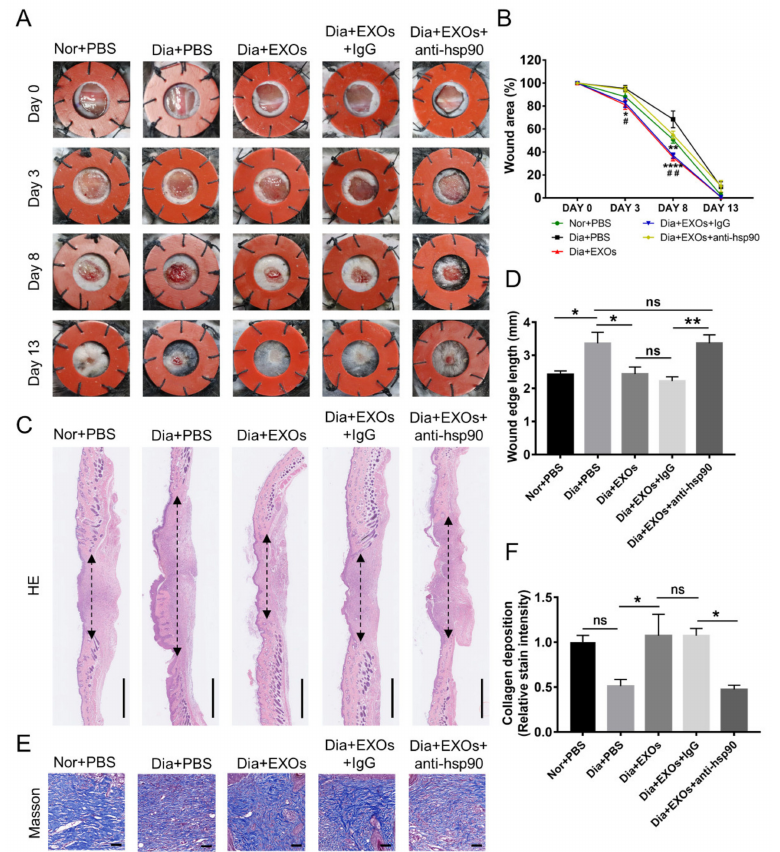
Figure 6. ADSC-EXOs accelerated skin wound healing in diabetic mice via eHSP90. ( A ) Representa- tive images of skin wounds at days 0, 3, 8, and 13. ( B ) Quantitative analysis of the wound-closure rates in different treatment groups; * vs. Dia + PBS, # vs. Dia + EXOs + anti-hsp90. ( C ) H & E staining analysis of wound sections on day 13 post wounding; the double-headed arrows represent edges of the granulation; scale bar: 1 mm. ( D ) Quantification of the wound edge length shown in ( C ). ( E ) Evaluation of collagen deposition by Masson’s trichrome staining in each group; scale bar: 50 µ m. ( F ) Qualification of the stain intensity of blue collagen shown in ( E ). n = 7. * p < 0.05, ** p < 0.01, **** p < 0.0001, ## p <